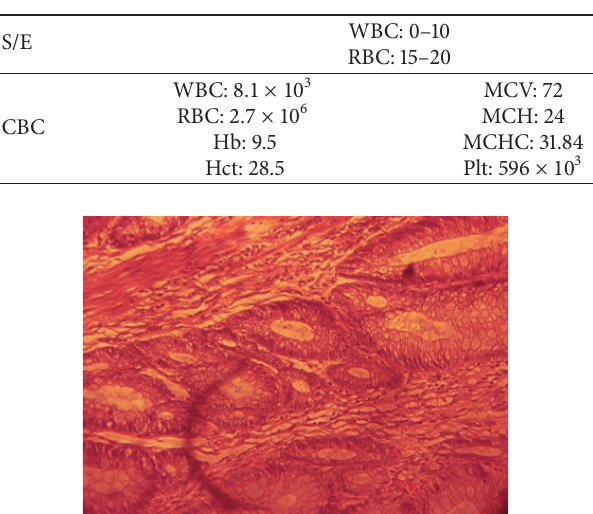
Figure 1: Tubular adenoma (case 1)—high power.